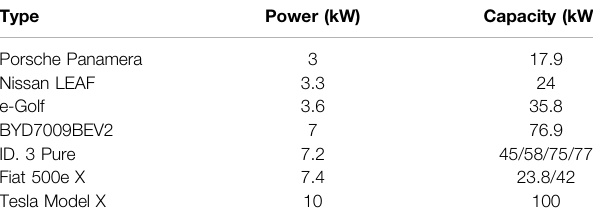
TABLE 1 | Battery parameters of typical